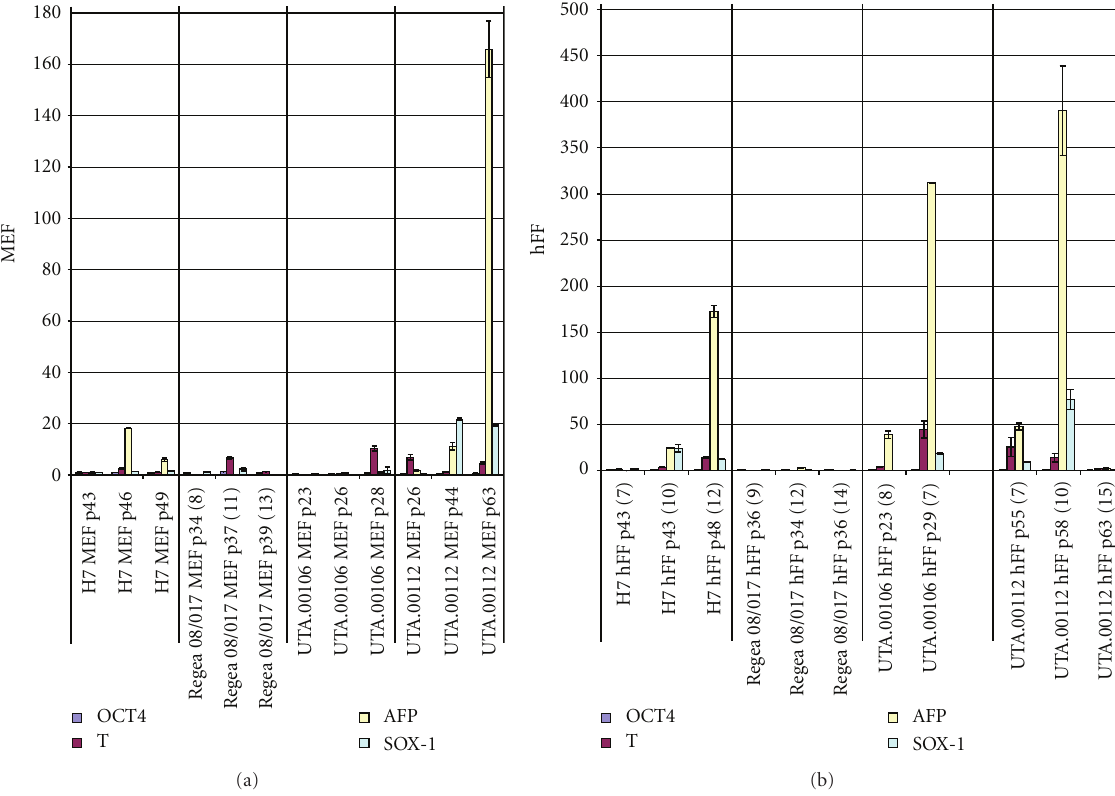
Figure 2: Relative gene expression levels of the undi ff erentiated stem cell lines on MEF (a) and on hFF (b). The H7 MEF p 43 sample has been used as the calibrator for all samples. Regea 08/017 has modest and steady expression levels of germ layer markers, whereas the expression levels in the iPS cell lines vary between